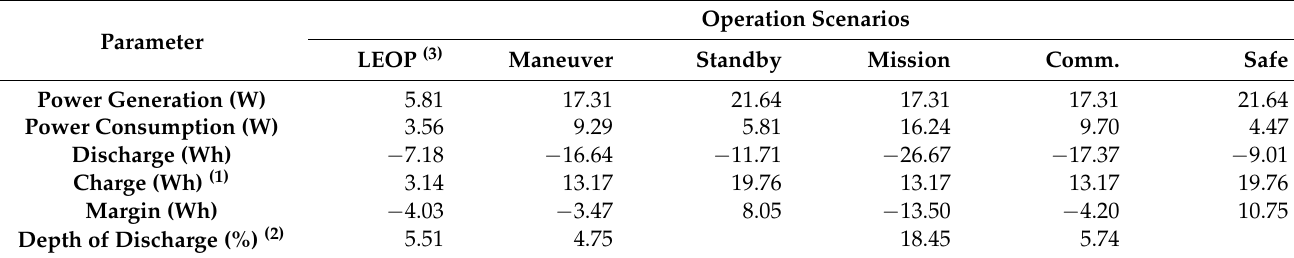
Table 9. Electrical power budget for each operation